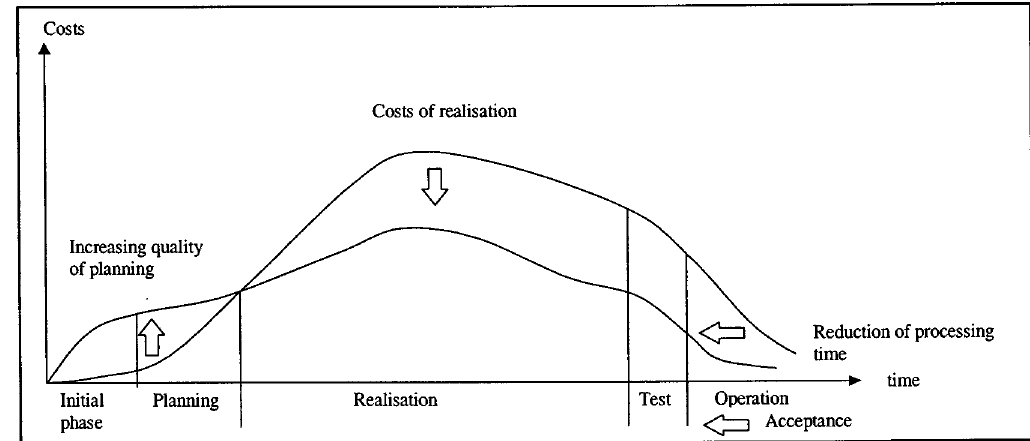
Fig 1 . Potential through the use of risk management in construction